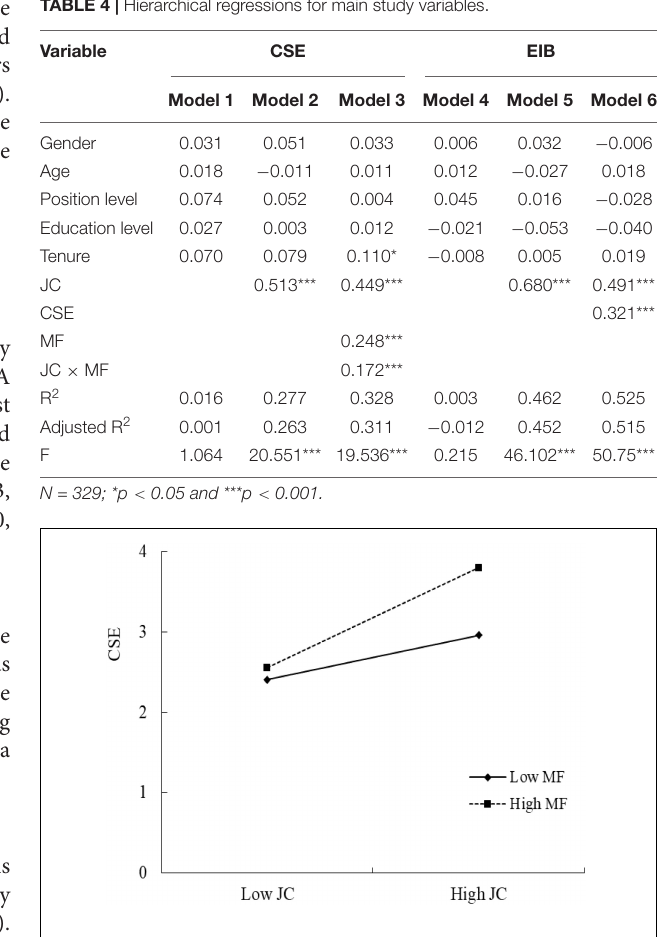
TABLE 4 | Hierarchical regressions for main study variables.